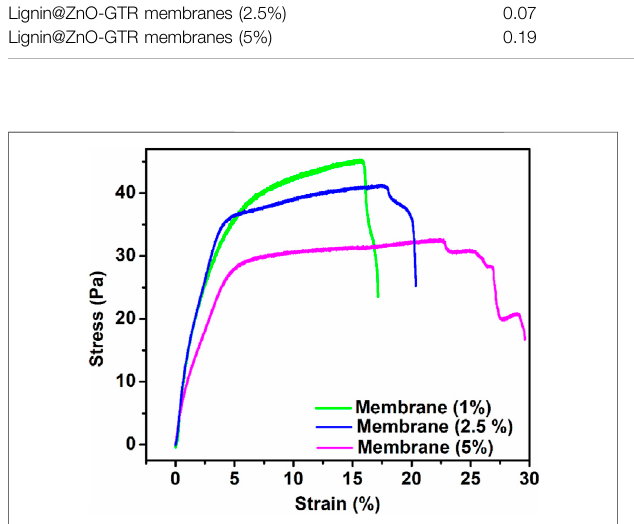
FIGURE. 5 | Strain (percentage) and tensile strength of the synthesized membrane having a different ratio of ZnO NPs.